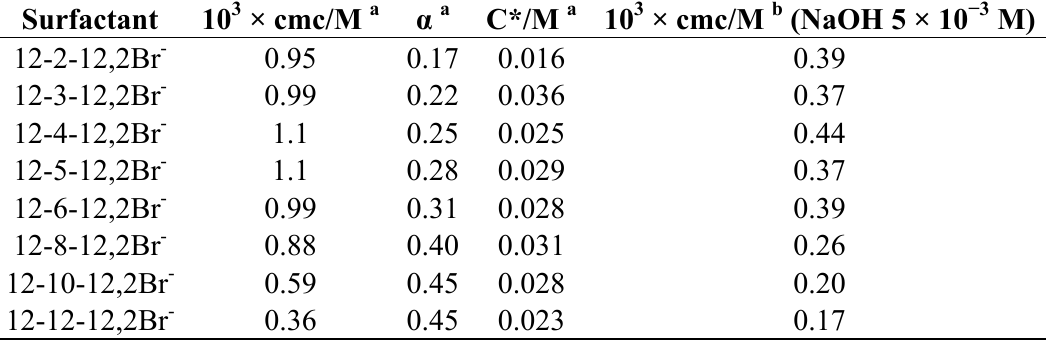
/I ratio on surfactant concentration in I III